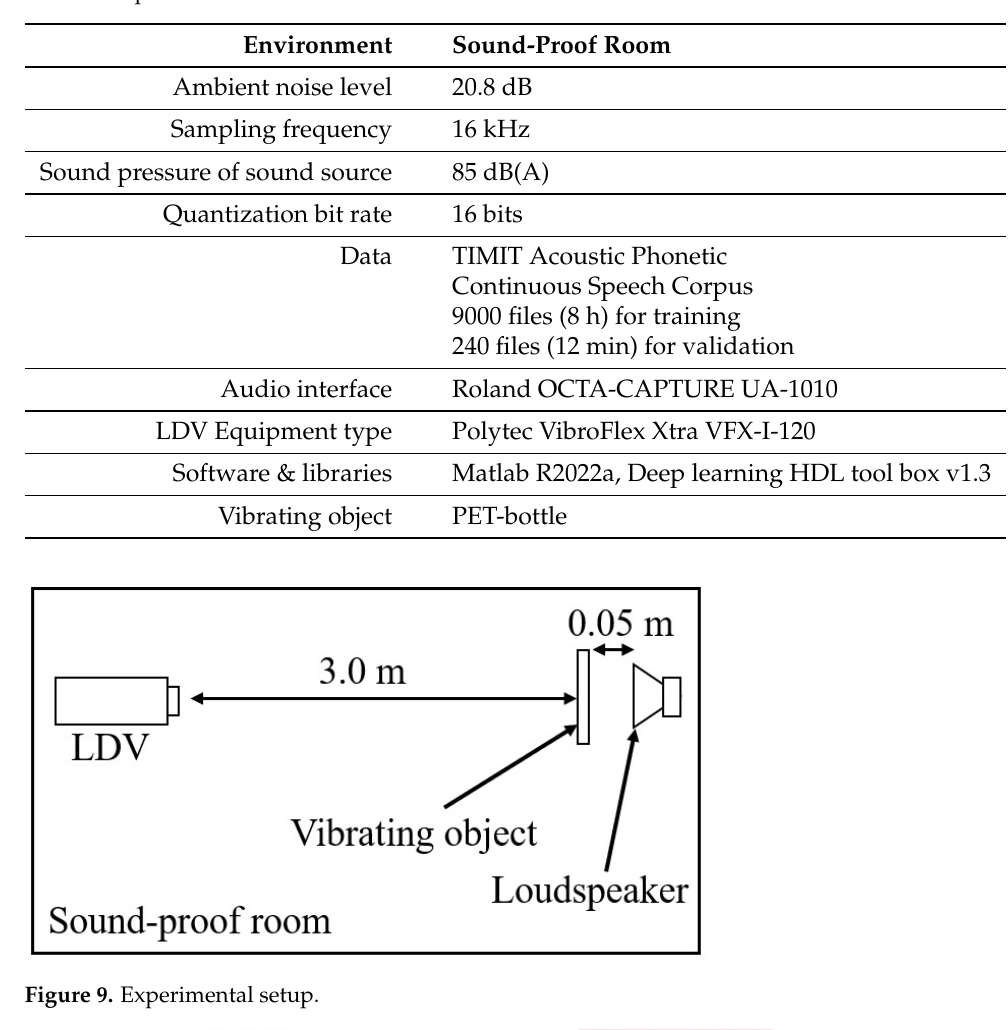
Table 2. Experimental conditions.